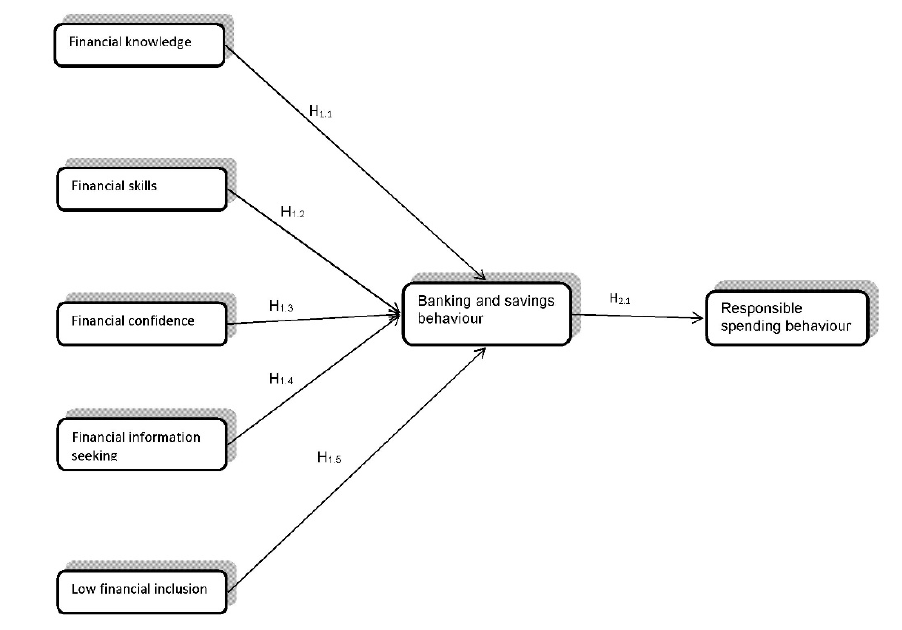
FIGURE 1: Adapted theoretical framework Source: Researchers’ own construct following the EFA